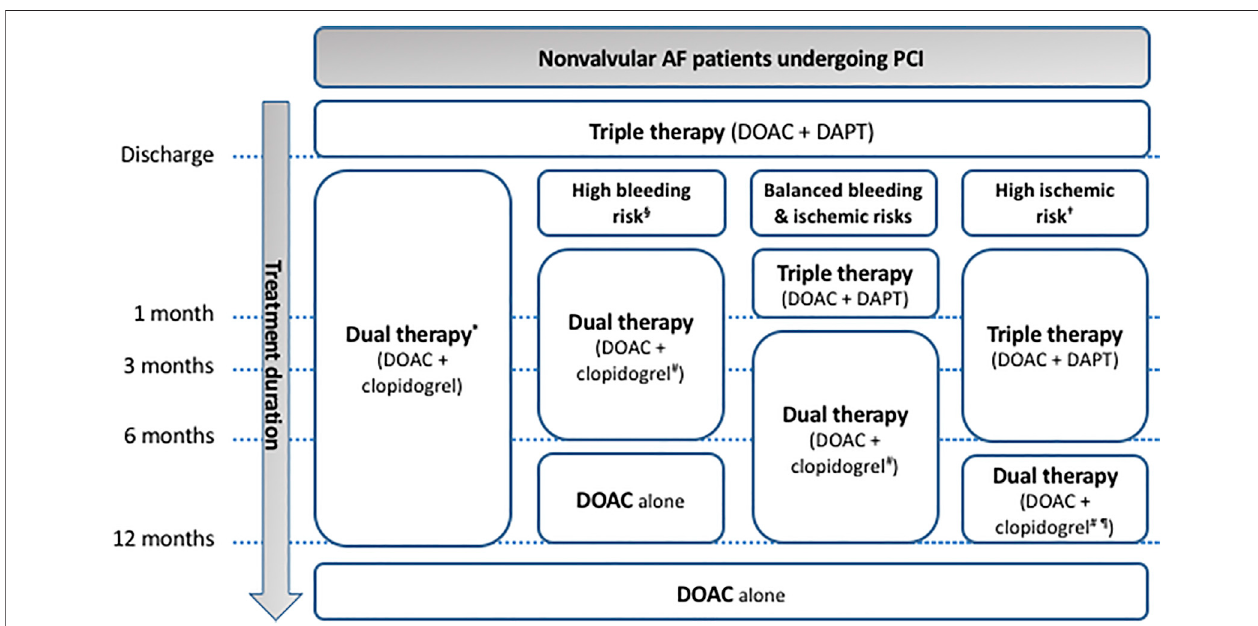
FIGURE 3 | Antithrombotic therapy in nonvalvular AF patients undergoing PCI. * default strategy recommended by the American guidelines irrespective of the bleeding/ischemic risk strati fi cation. § advanced age (older than 75 years), frailty, anemia with hemoglobin < 110 g/L, chronic renal failure (creatinine clearance < 40